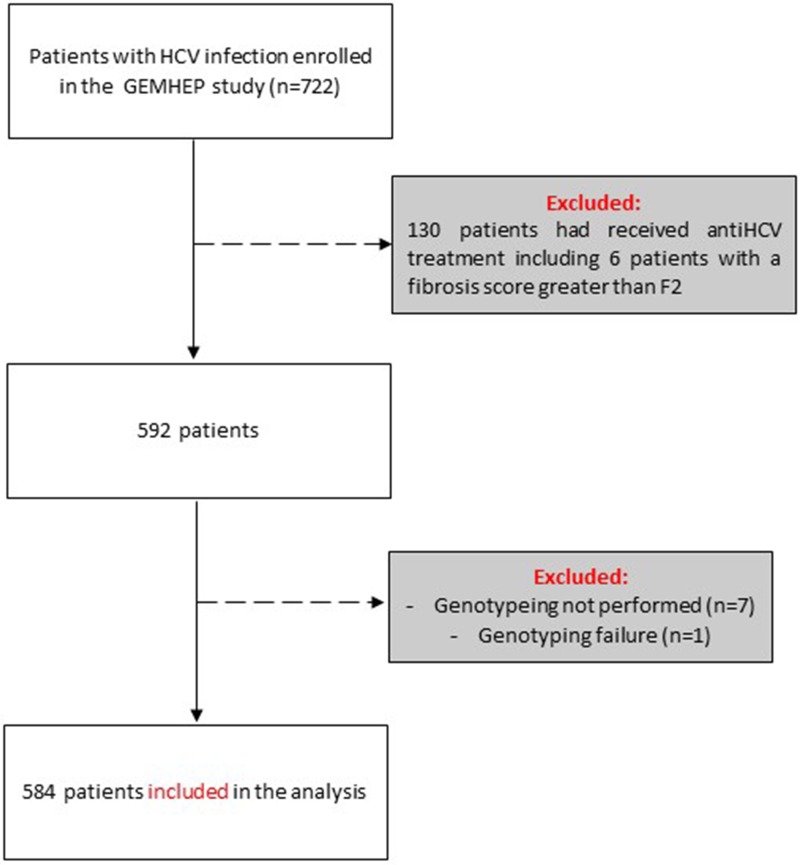
Flow chart of patient inclusion in the GEMHEP study. Patients excluded from the study are indicated in grey boxes.